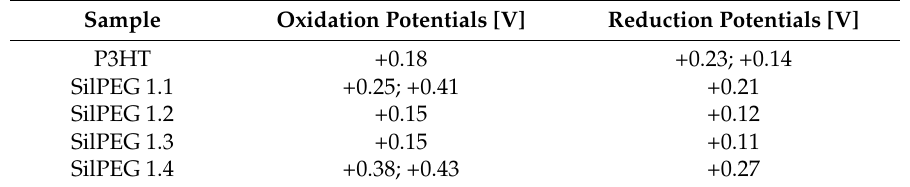
Table 3. Oxidation and reduction potentials of the investigated films deposited via drop-casting on the Pt wire